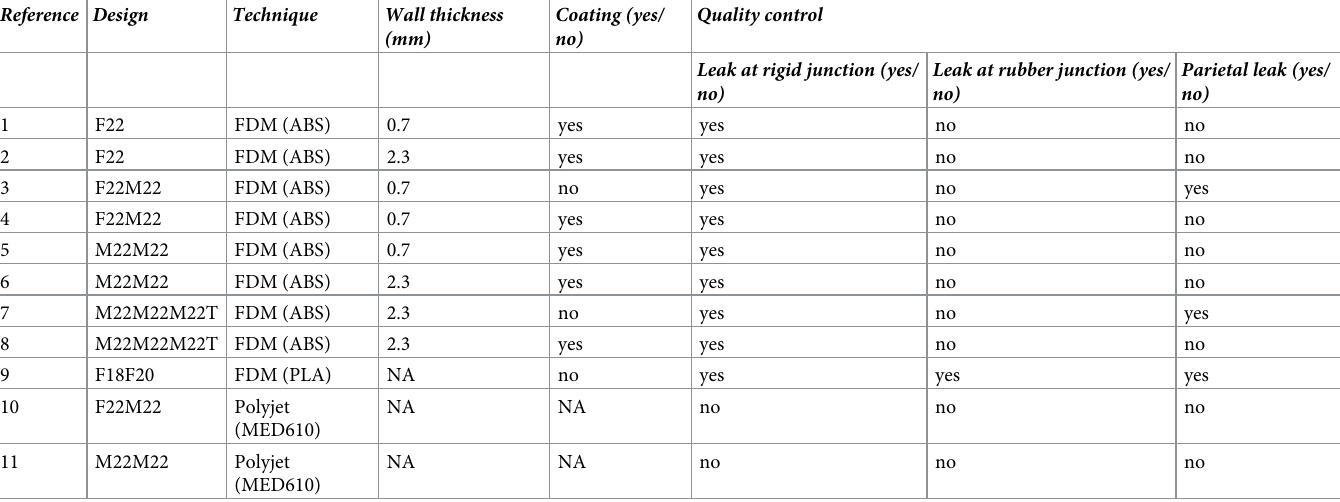
Table 1. Printing characteristics and quality control for non-intentional leaks. Reference